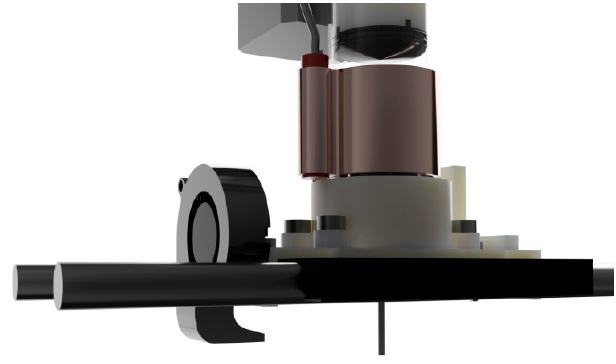
Figure 9. Fan design for forced cooling of printed part.